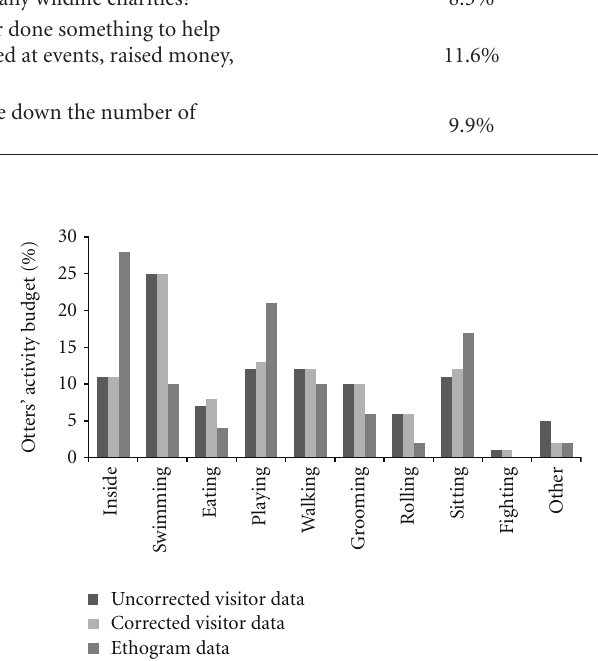
Figure 4: Di ff erences in otters’ activity budgets calculated using corrected and uncorrected visitor data and ethogram